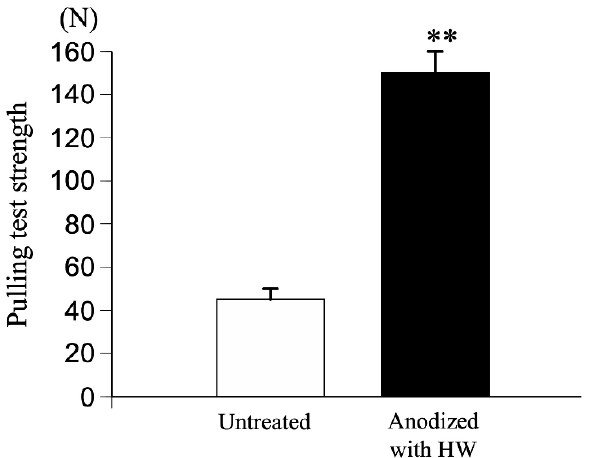
Figure 4. Comparison of pull-out strength of TiNbSn rods treated by acetic acid anodization with hot water treatment and untreated TiNbSn rods . Pull-out strength was assessed six weeks after TiNbSn rod implantation into rabbit femurs. **: p < 0.01 using Student’s t test. HW: hot wa- ter.